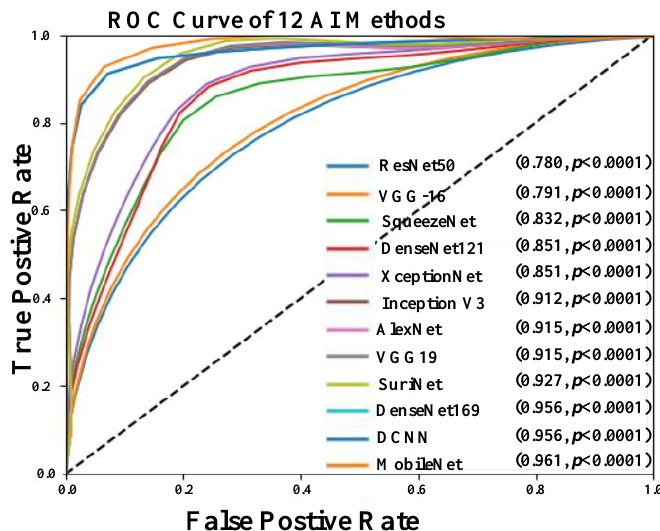
Figure 15. ROC comparison of 12 AI models (10 TL and 2 DL).